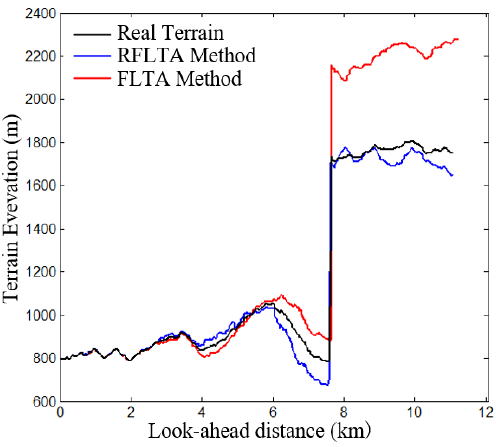
Figure 10. Two boundaries on the horizontal flight curve.